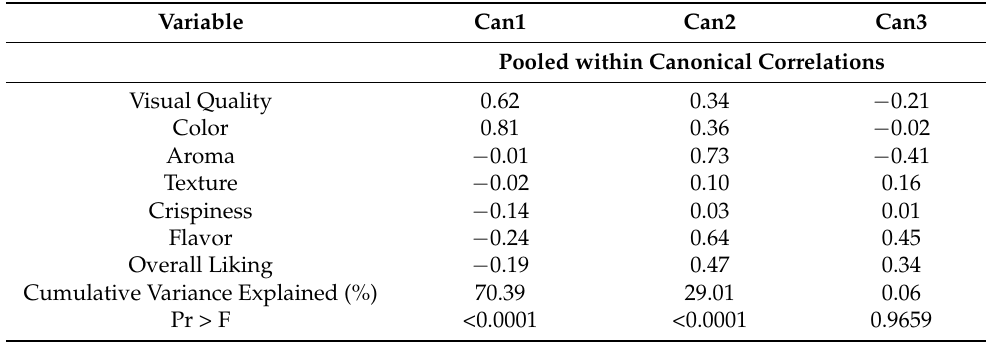
Table 3. Descriptive discriminant analysis using liking scores (a 9-point hedonic scale; N = 115 consumers) for catfish skin